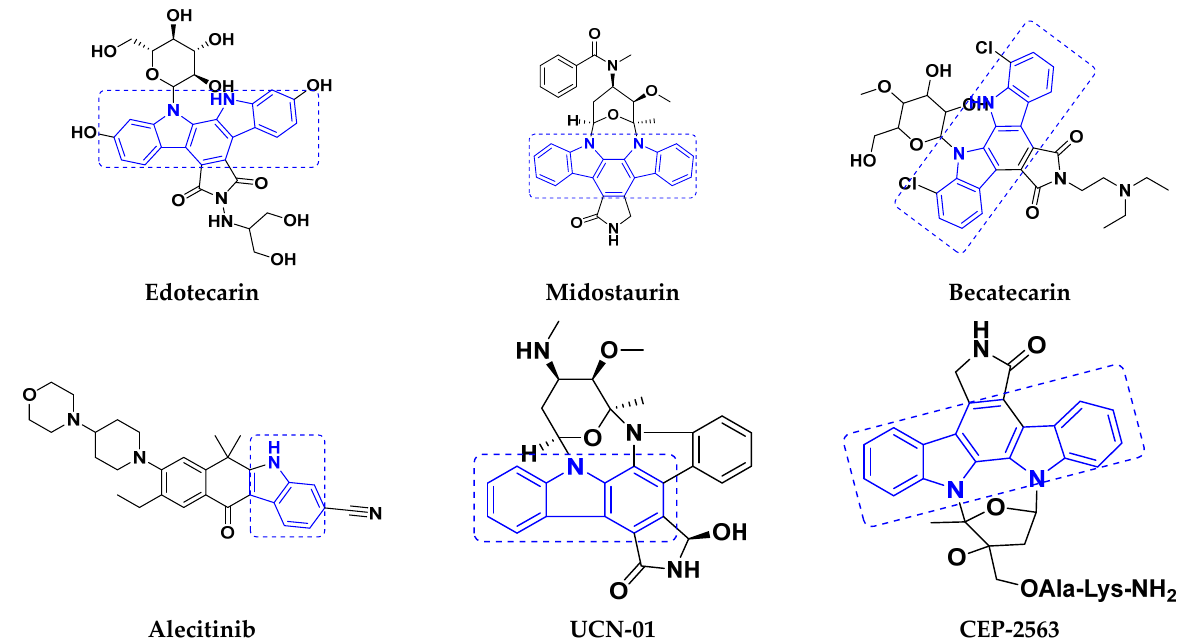
Figure 24. Carbazole hybrids that are FDA approved/or under clinical trials. Table 21. Current status of carbazole ‐ based hybrid drugs that are approved/or under clinical trials.